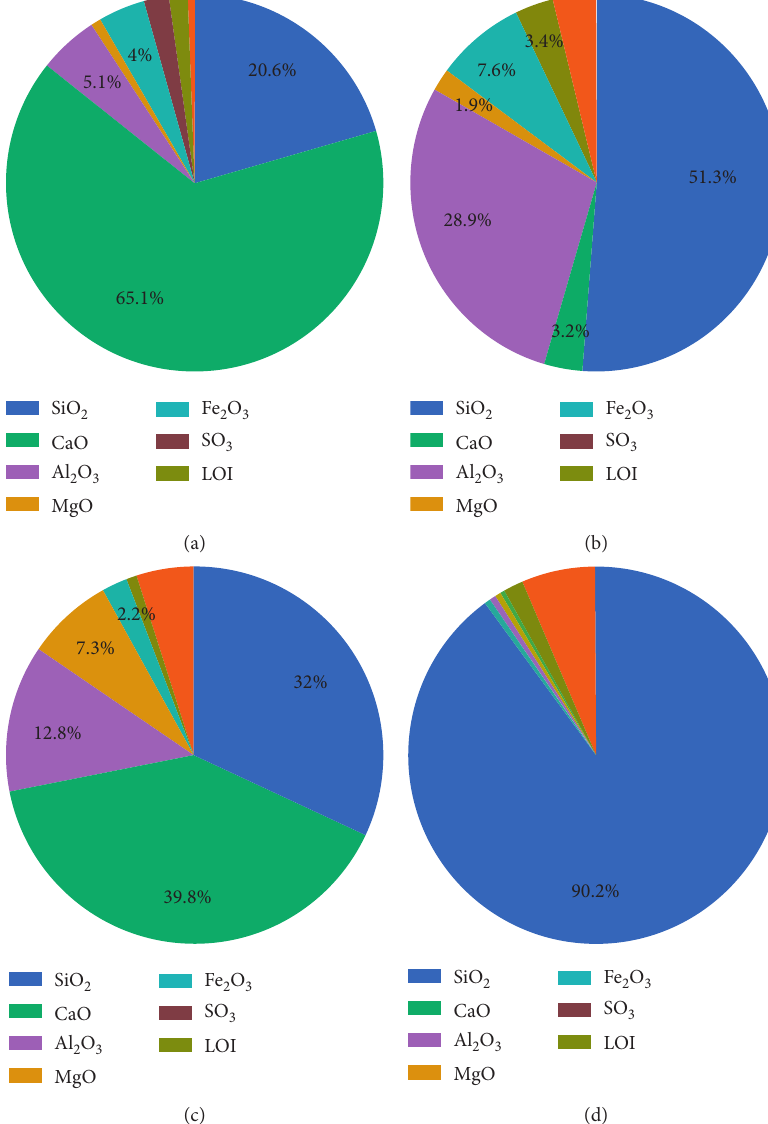
Figure 1: Chemical composition results of binders: (a) OPC. (b) FA. (c) BFS. (d)